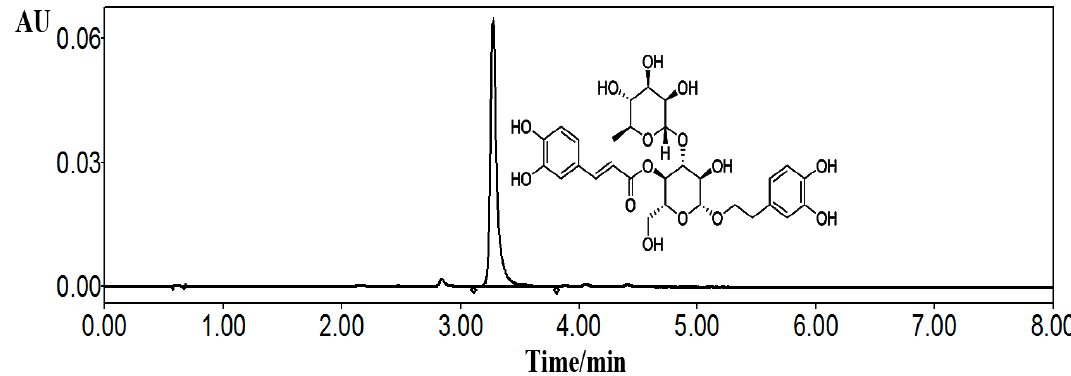
Figure 8. Chemical structure and ultra high performance liquid chromatography (UHPLC) chromatogram of acteoside. The chromatographic conditions were as follows: XBridge BEH C 18 column (2.1 mm × 100 mm; 1.7 µm, Waters, Milford, MA, USA) at ambient temperature; mobile phase contained water with 0.5% v / v acetic acid (solvents A) and acetonitrile (solvents B), the gradient elution were: 0–2 min, 85–83% A; 2–5 min, 83–80% A; 5–8 min, 80–78% A; the flow rate was 0.4 mL / min and sample injection volume was 1 µ L; the detection wavelength was 333 nm. Acteoside was dissolved in methanol for UHPLC